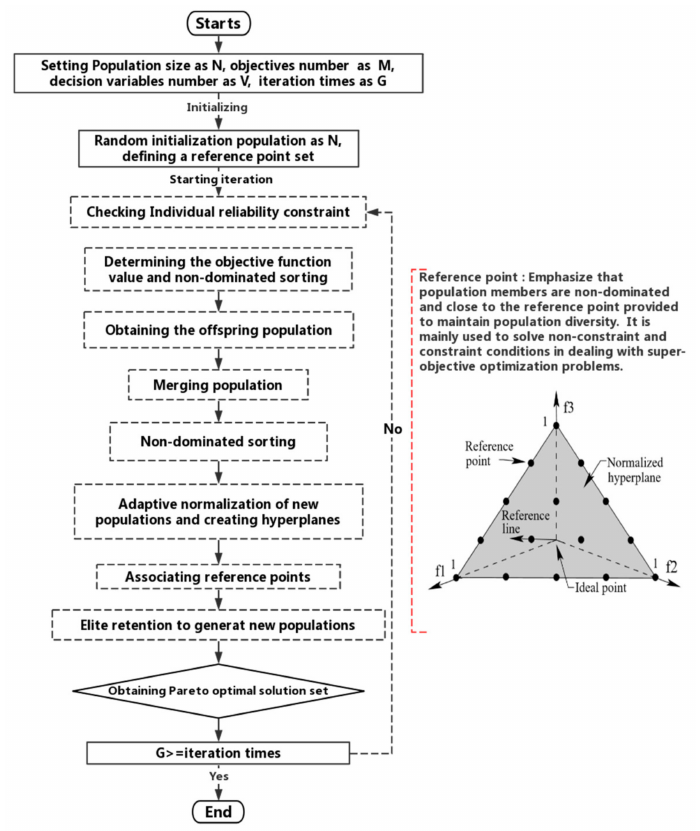
Figure 3. Calculation flowchart of NSGA-III.